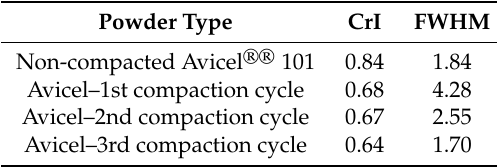
Table 2. CrI and FWHM values for non-compacted and compacted